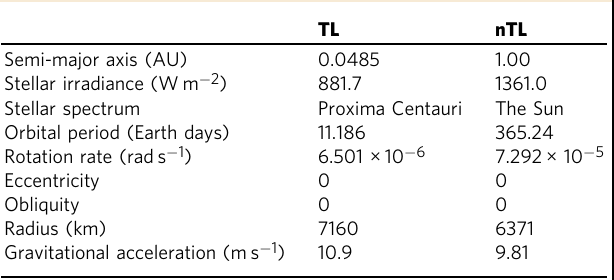
Table 1 Orbital and planetary properties.